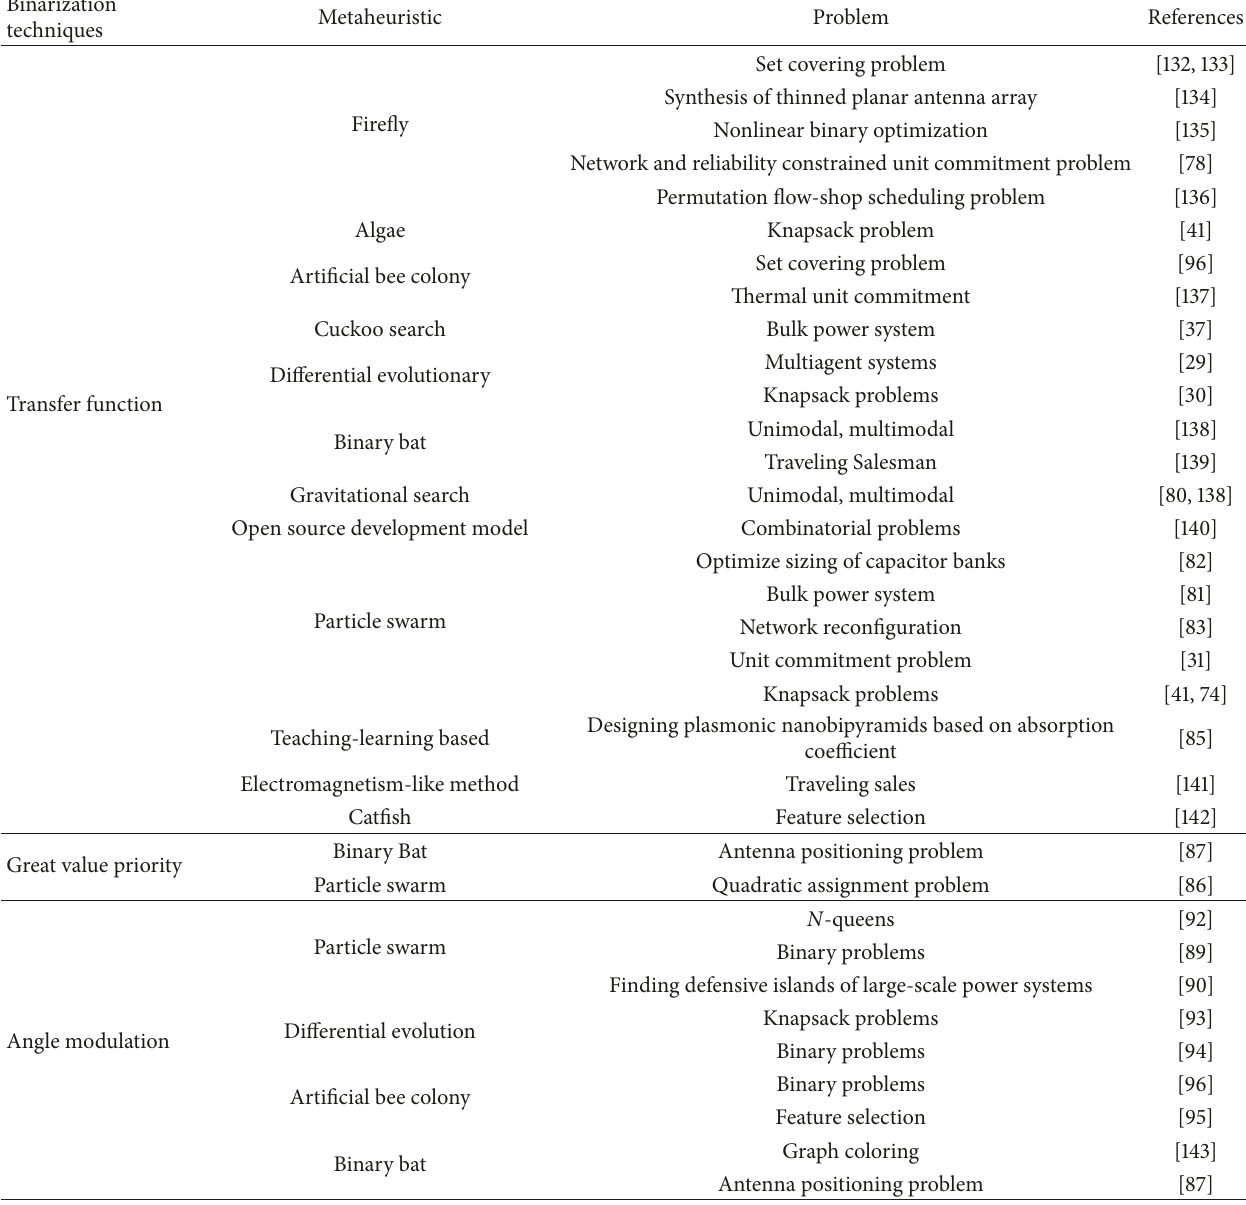
Table 5: Summary of two-step binarization